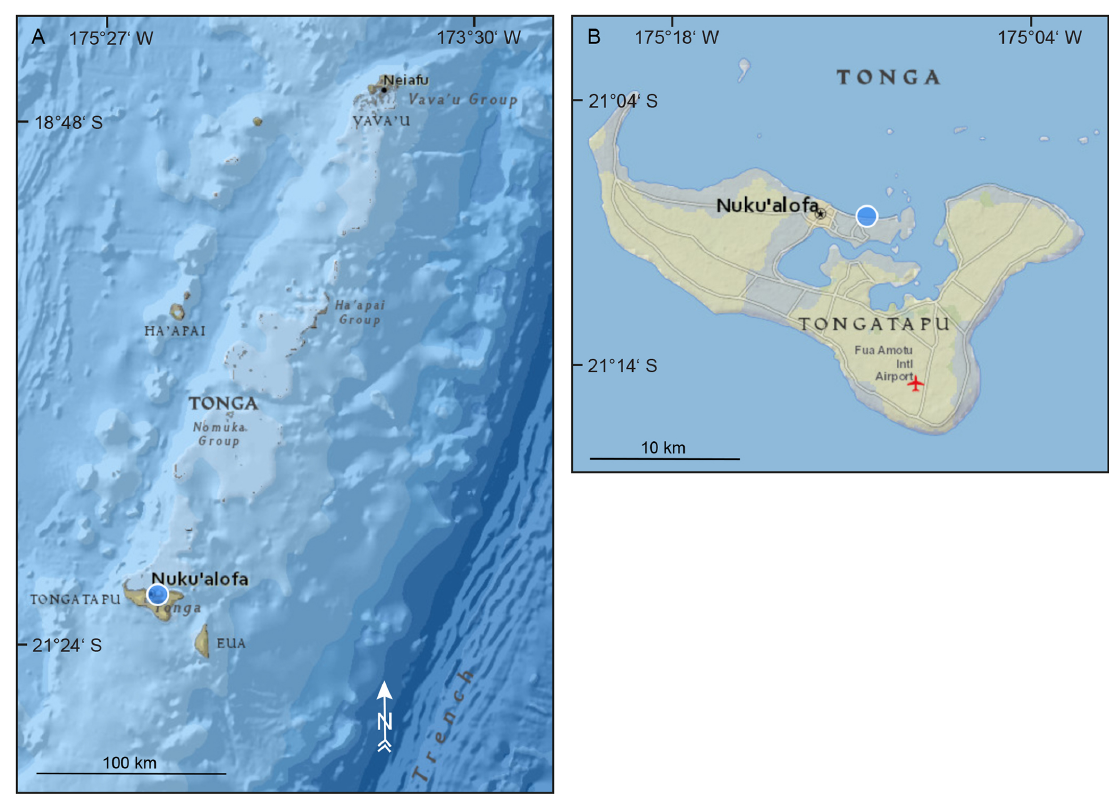
Figure 6. Map showing Tonga. Study site on Tongatapu is indicated by a blue circle. Basemap: “National Geographic Map”, with data from National Geographic, Esri, Garmin, HERE, UNEP-WCMC, USGS, NASA, ESA, METI, NRCAN, GEBCO, NOAA and INCREMENT P Corp. Table 1. Different types of RSL indicators reviewed in this